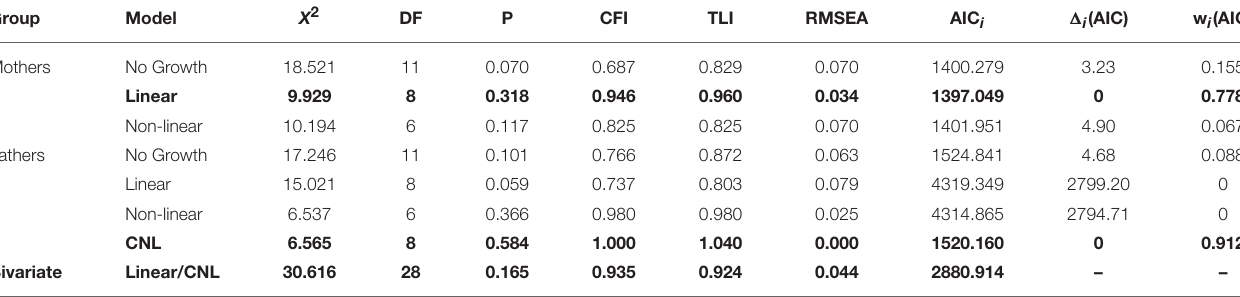
TABLE 3 | Indices of model